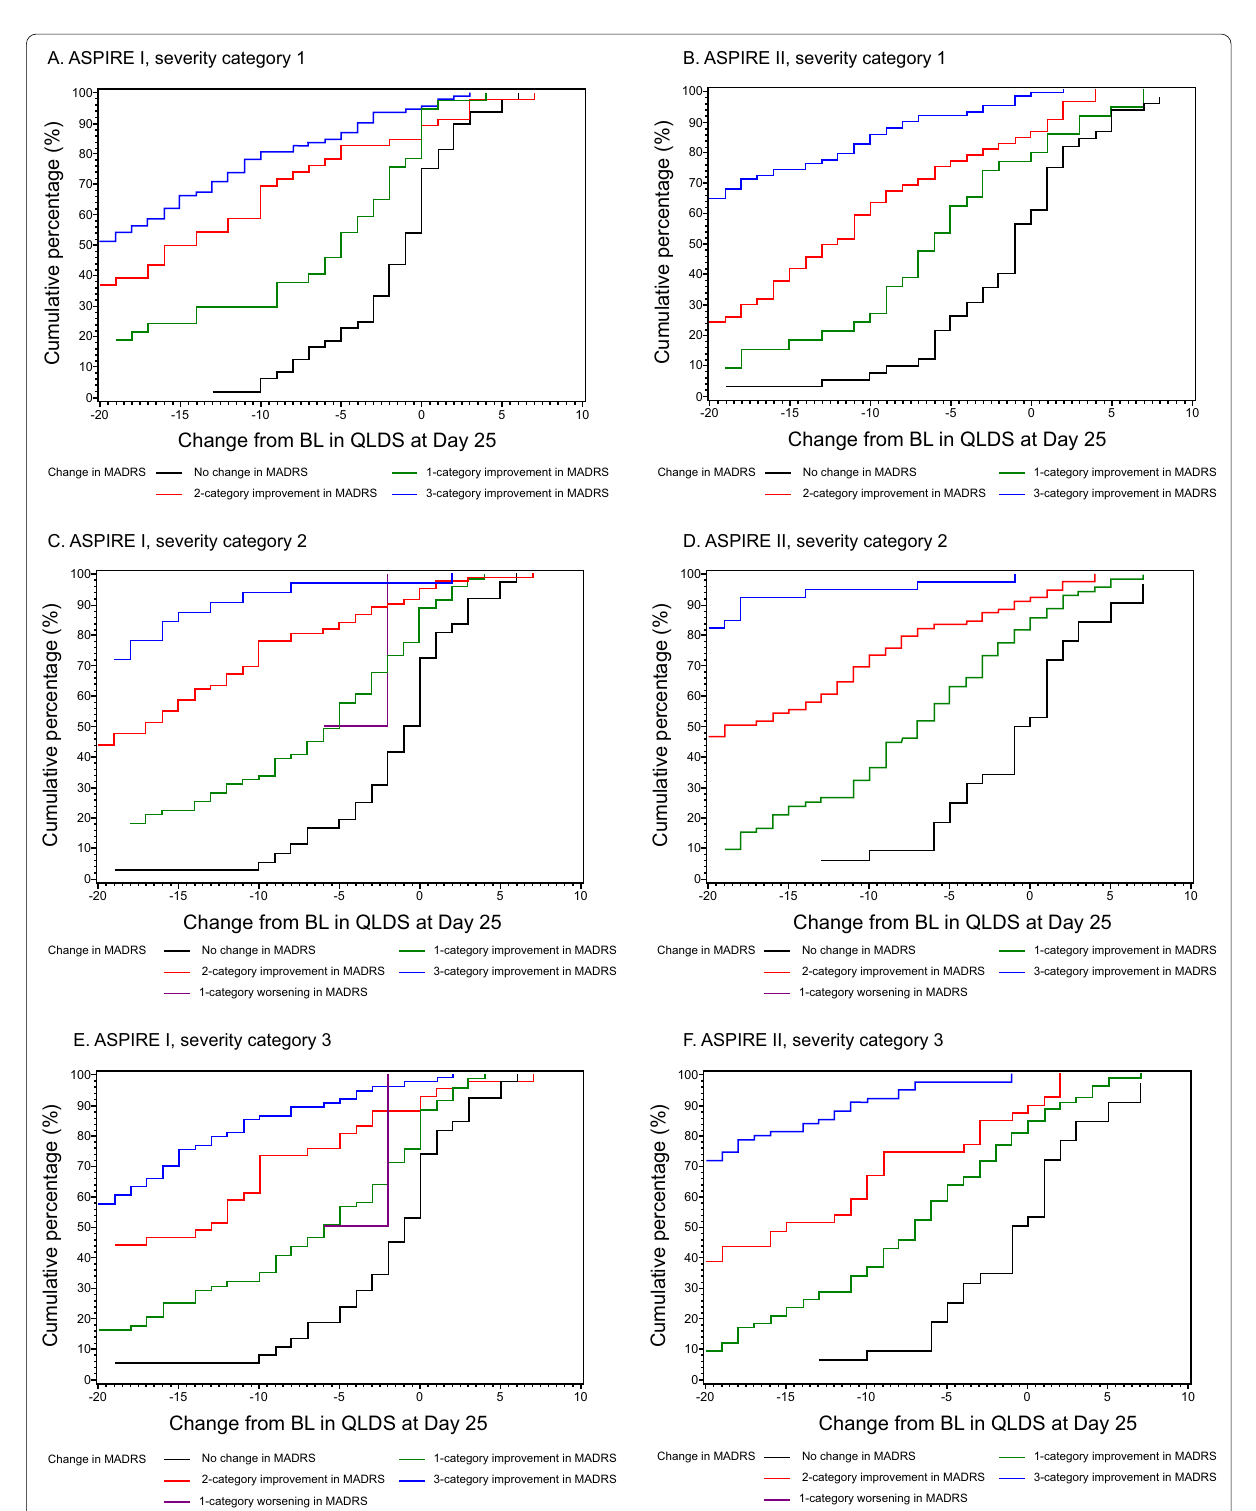
Fig. 4 Cumulative distribution function of change from baseline to Day 25 in QLDS score stratified by MADRS change category at Day 25. A , B : Severity Criteria #1; C , D : Severity criteria #2; E , F : Severity Criteria #3 (see Table 1 for details). BL Baseline, IMP Improvement, MADRS Montgomery– Åsberg Depression Rating Scale, QLDS Quality of Life in Depression